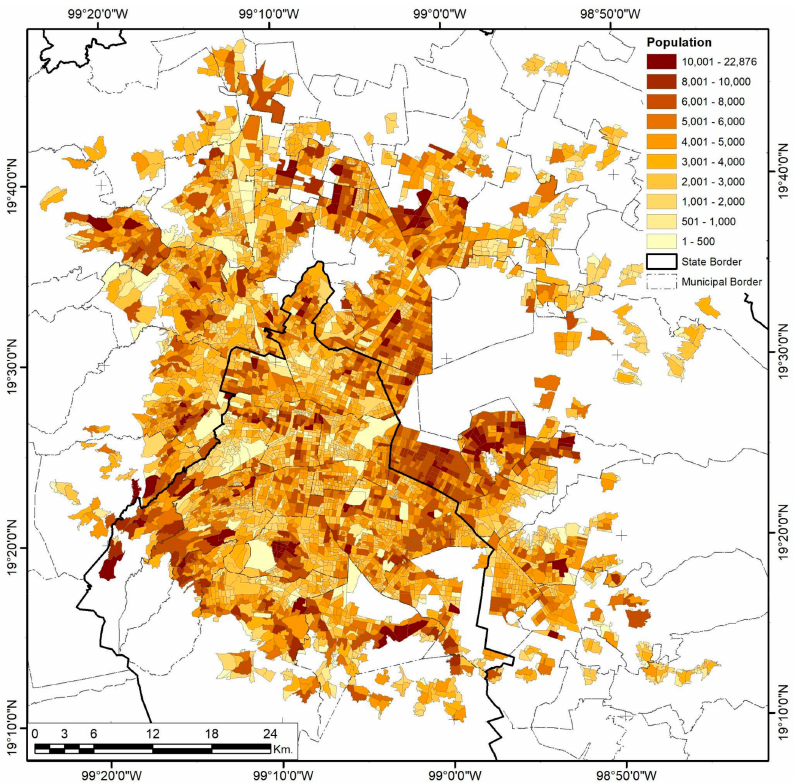
Figure 15. Mexico City population density by AGEB. Developed by the authors with data from